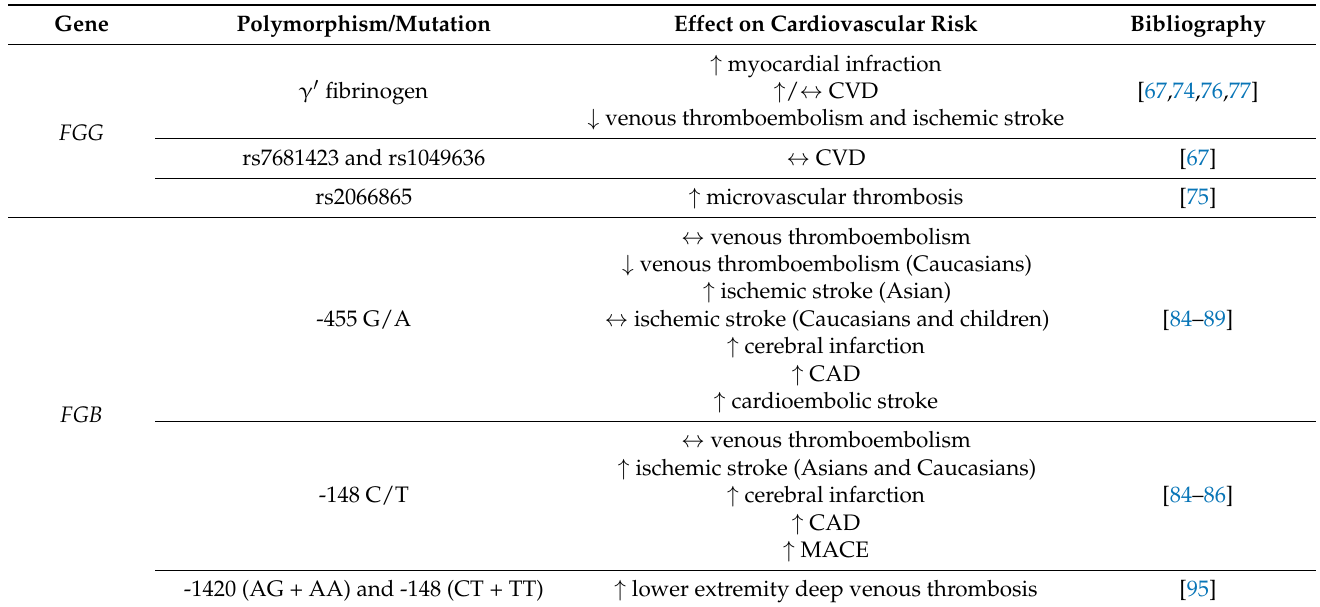
Table 3. Fibrinogen molecular modifications and cardiovascular risk. CVD - cardiovascular disease; CAD—Coronary artery disease; MACE—major adverse cardiovascular